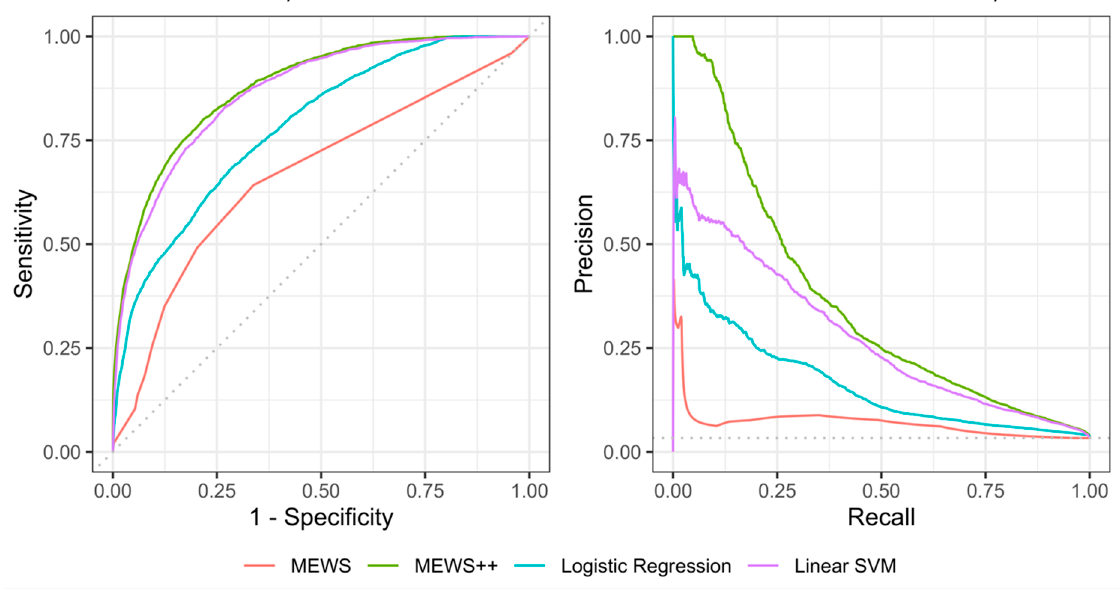
Figure 2. ROC and AUC PR Curves. Receiver Operating Characteristic (ROC) curves (left panel) and Precision-Recall curves (right panel) for the four models evaluated. MEWS++ (RF) performs better than other algorithms. LR—Logistic Regression, SVM = Support Vector Machine.